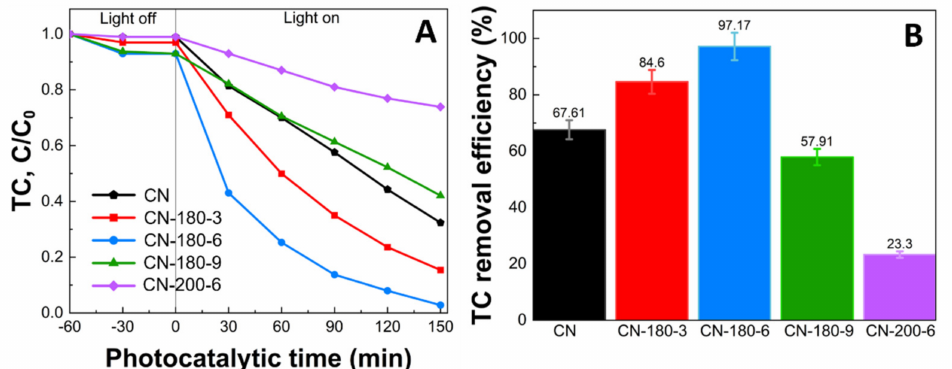
Figure 6. Photodegradation efficiency of TC by CN-180-x and CN-200-6 under visible light irradiation (140W xenon lamp, λ > 420nm) ( A ) C/C 0 vs. t (Initial condition: 20 mg L − 1 TC, 0.2 g L − 1 catalyst, pH = 4.40, 20 ◦ C), and ( B ) TC removal efficiency